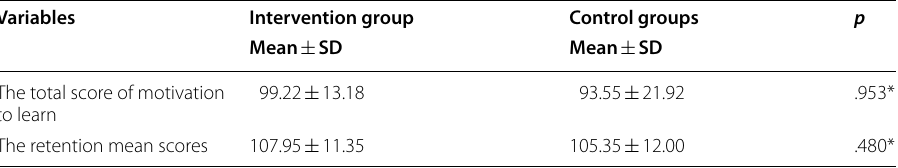
Table 3 Comparison of total motivational learning scores in the intervention and control groups before and after the